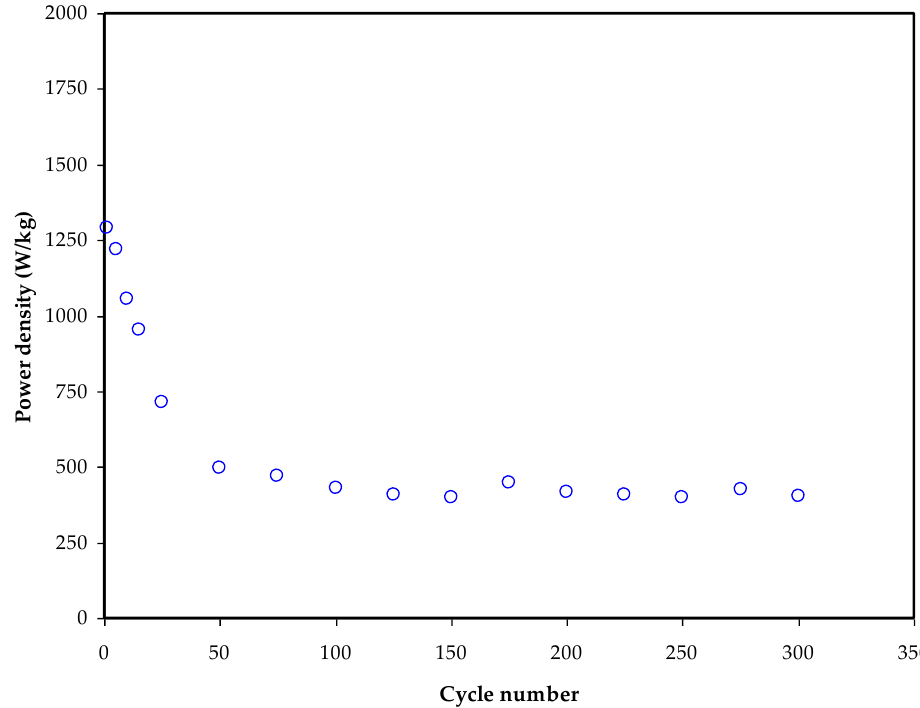
Figure 9. Power density ( P d ) of the constructed EDLC against cycle number.